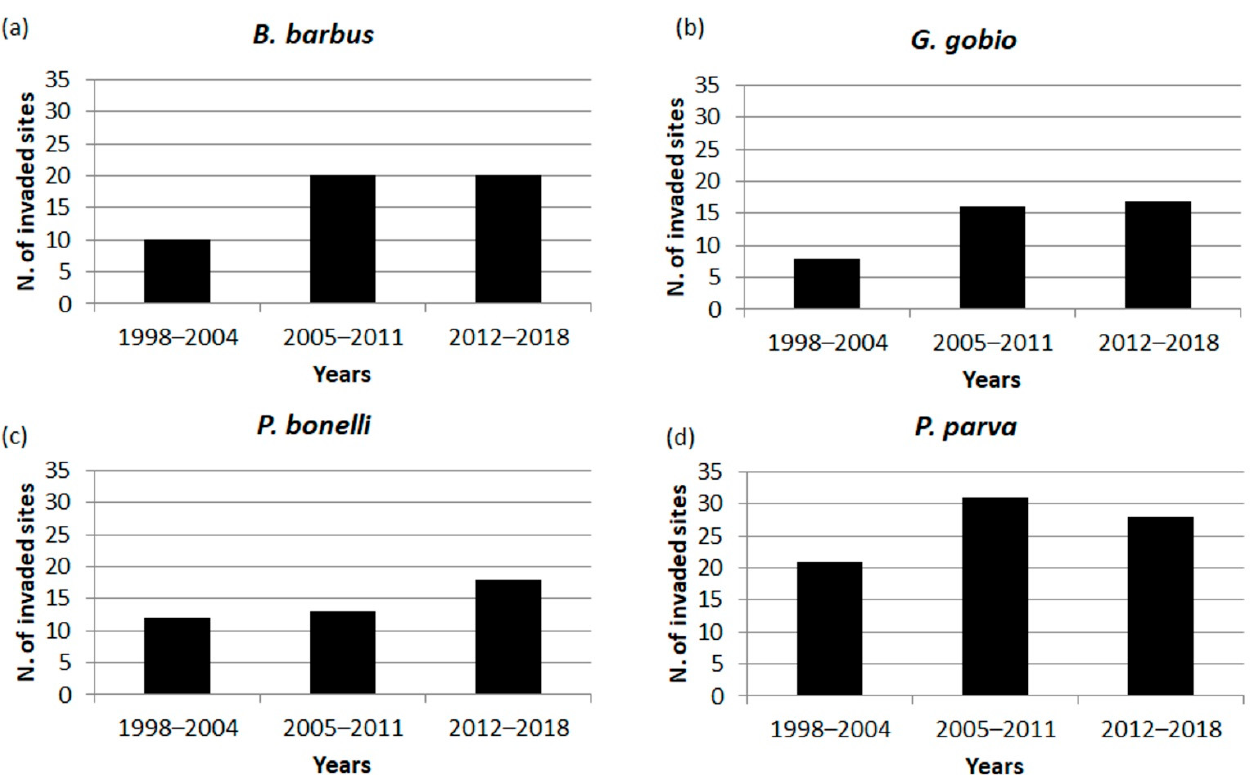
Figure 3. Number of invaded sites over the three census periods for: ( a ) B. barbus , ( b ) G. gobio , ( c ) P. bonelli , ( d ) P. parva